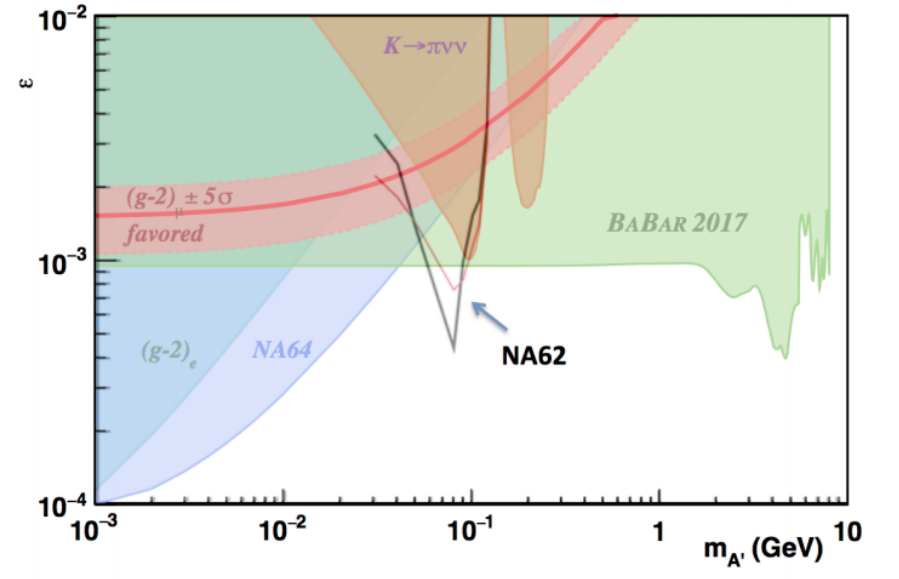
Figure 6. Upper limits (at 90% CL) in the plane coupling ( (cid:101) ) vs. Dark Photon (DP) mass for DP to invisible decays